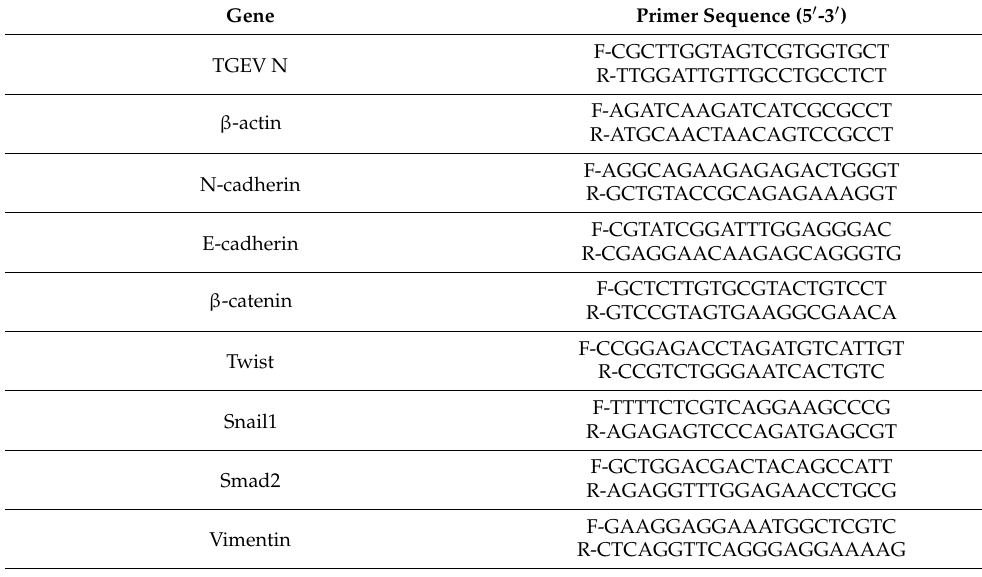
Table A1. Reaction systems and primers of RT-PCR.